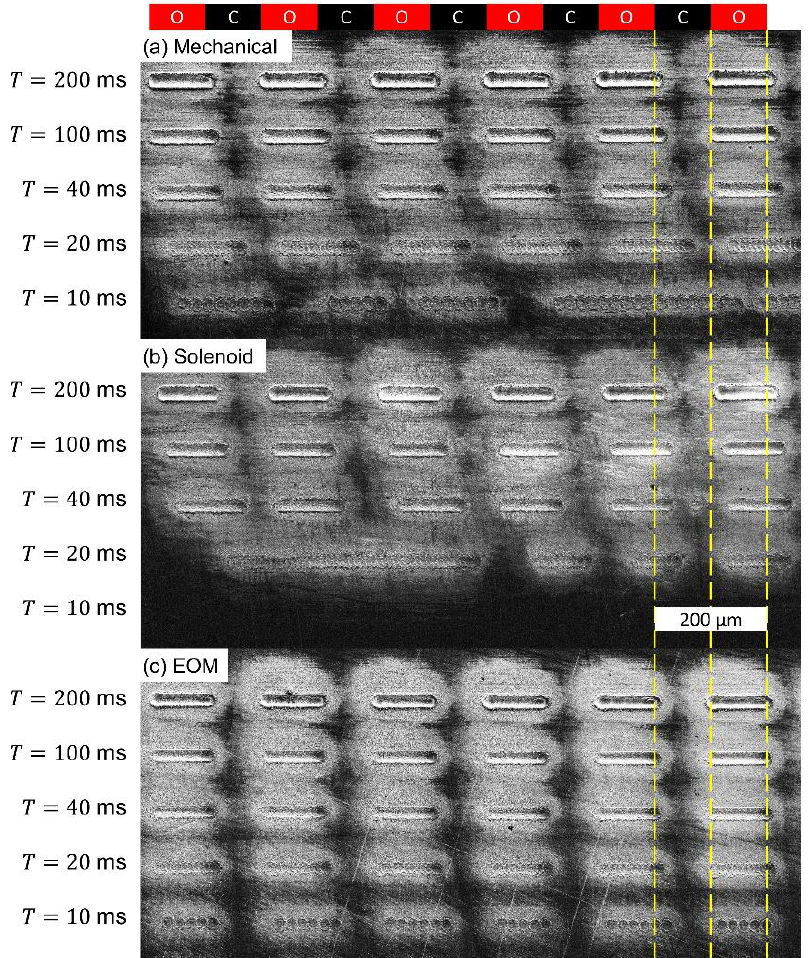
Figure 8. SEM micrographs demonstrating the performance of different shutters when subjected to a cycling open/closed signal with varying period. Ideally, each ablated line should be 100 µm long, and remain aligned with those above it. ( a ) Mechanical shutter. ( b ) Solenoid Shutter. ( c ) EOM shutter.